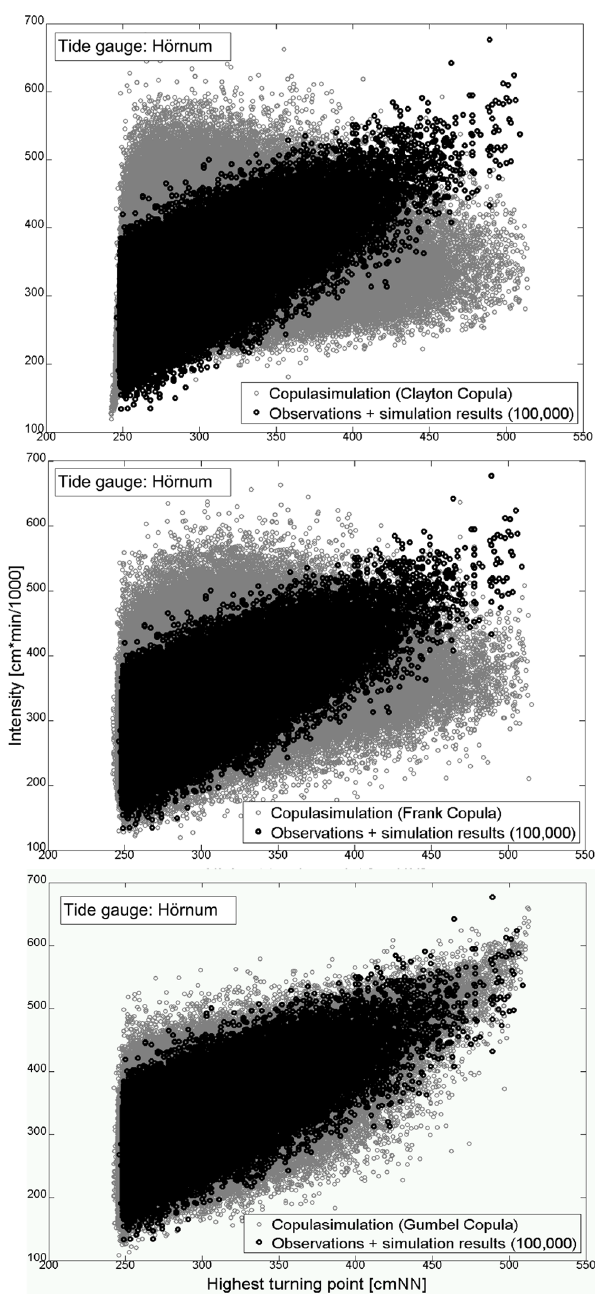
Fig. 8. Results from a graphical based GoF test for the tide gauge of H¨ornum and for the Clayton Copula (top), the Frank Copula (mid- dle) and the Gumbel Copula